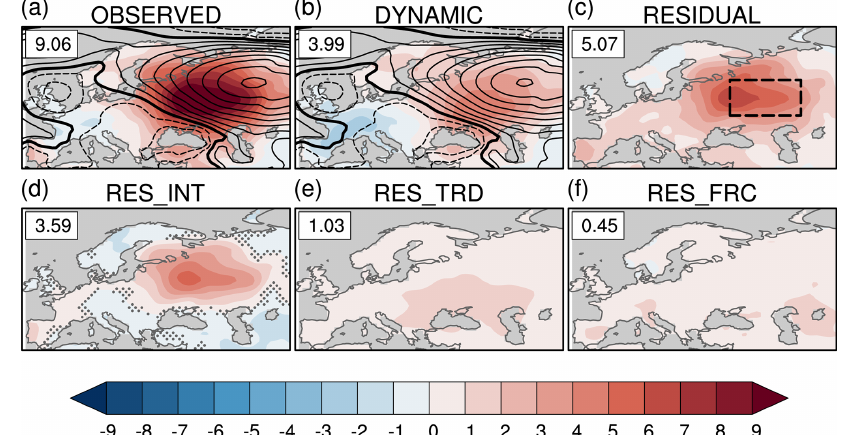
Figure 3. BERK daily maximum temperature (TX, ◦ C, shading) and 20CR_V3 sea level pressure (SLP, hPa, black line contours with contour interval of 1hPa) anomalies averaged over the Russian heat wave period (15 July–14 August 2010): (a) total TX anomaly and observed SLP anomaly, (b) TX dynamic component contribution and reconstructed SLP anomaly, (c) TX total residual contribution, (d) TX internal residual contribution, (e) TX long-term trend residual contribution and (f) TX residual contribution from forced changes in other factors. Numbers in the upper right corner indicate the weighted average TX anomaly over the region delimited by the black dashed box in (c) . In (a) and (b) , the thick black contour line indicates the zero SLP anomaly, and dashed contour lines indicate negative SLP anomalies. In (d) , stippling indicates grid points where RES INT values are within the uncertainty range of the dynamic component given by the 95% confidence interval estimated by the bootstrap method given in Sect.